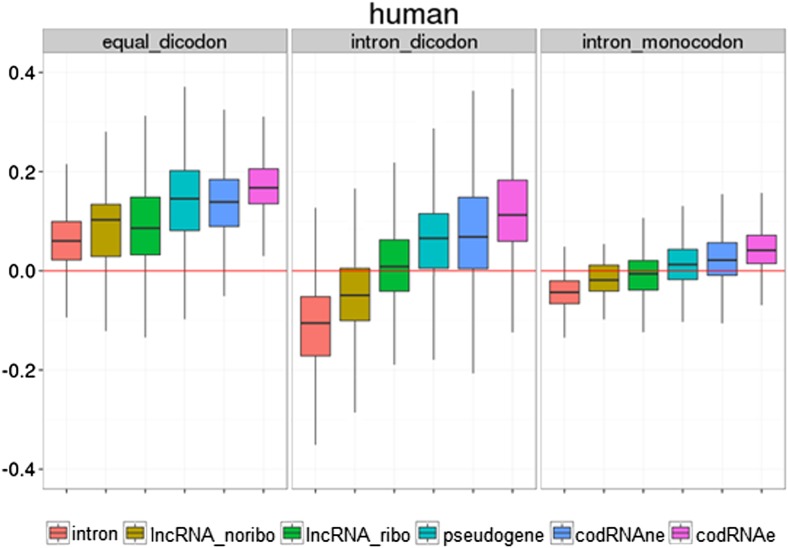
Use of different coding statistics in human transcripts.Equal dicodon was based on the observed hexamer frequencies in coding sequences vs hexamer equiprobability, intron dicodon was based on the differences between hexamer frequencies in coding vs non-coding sequences and intron_monocodon was based on the observed codon frequences in coding sequences vs codon equiprobability.